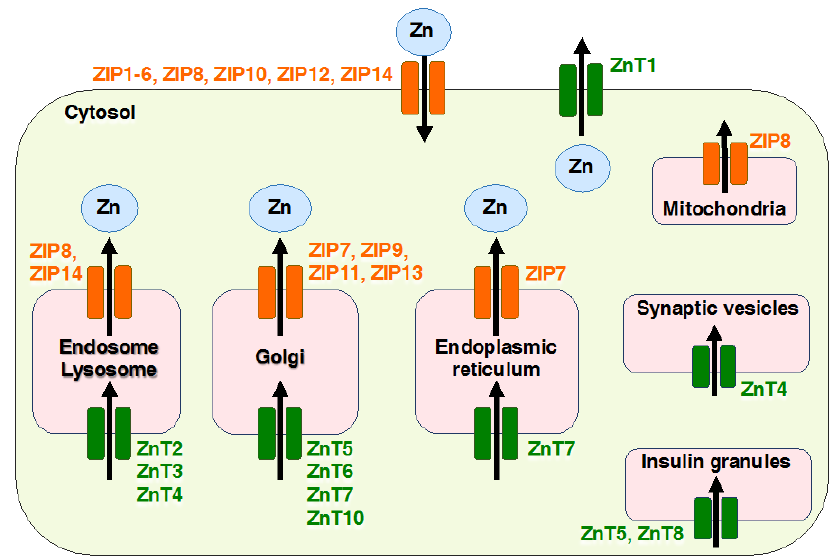
Figure 2. Cellular localization of Zinc transporters (ZnTs) and Zrt- and Irt-like proteins (ZIPs). The diagram shows the localization of ZIPs (orange) and ZnTs (green). The black arrow shows the direction of Zn transport in the plasma membrane and each organelle. ZIPs and ZnTs regulates the flux of Zn ion in the extra- or intra-cellular environment and tightly controls cellular Zn homeostasis in numerous cell types.